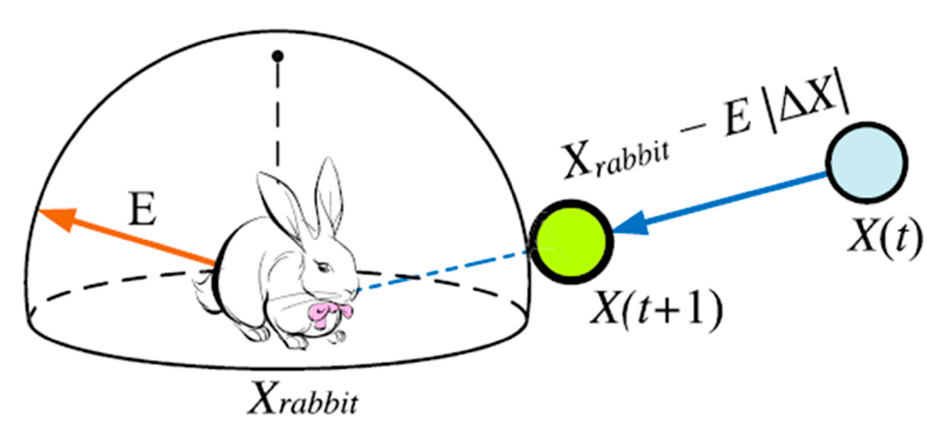
Figure 3. Hard siege scenario considering one hawk [50].